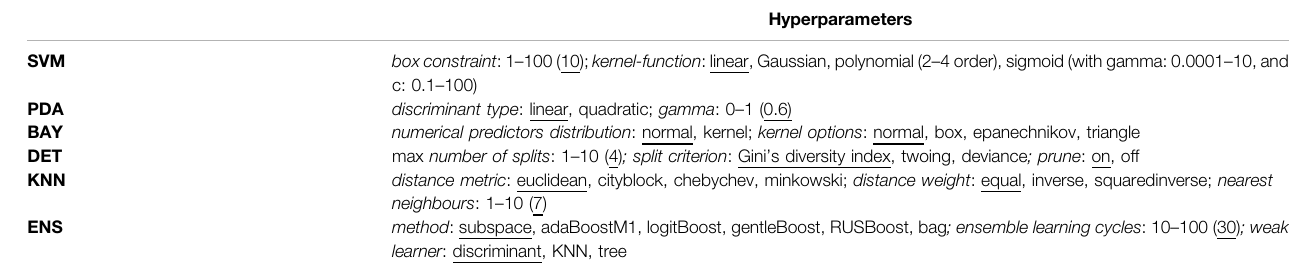
TABLE 1 | Hyperparameters of the classi fi cation algorithms, with tested values (range and options) and best choice (providing the largest accuracy, and used in the study) reported underlined.